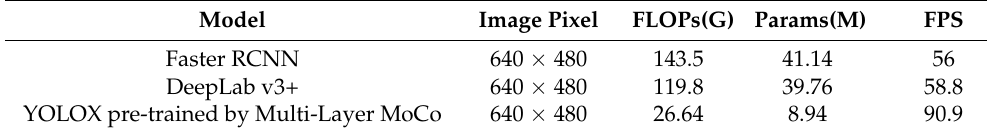
Table 6. Computational resource consumption, model size, and inference speed